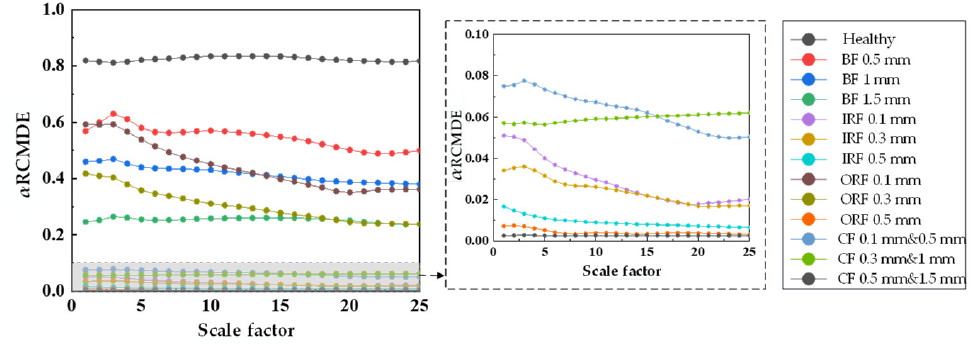
Figure 25. α RCMDE entropy values of 25 scale factors under different damage degrees.